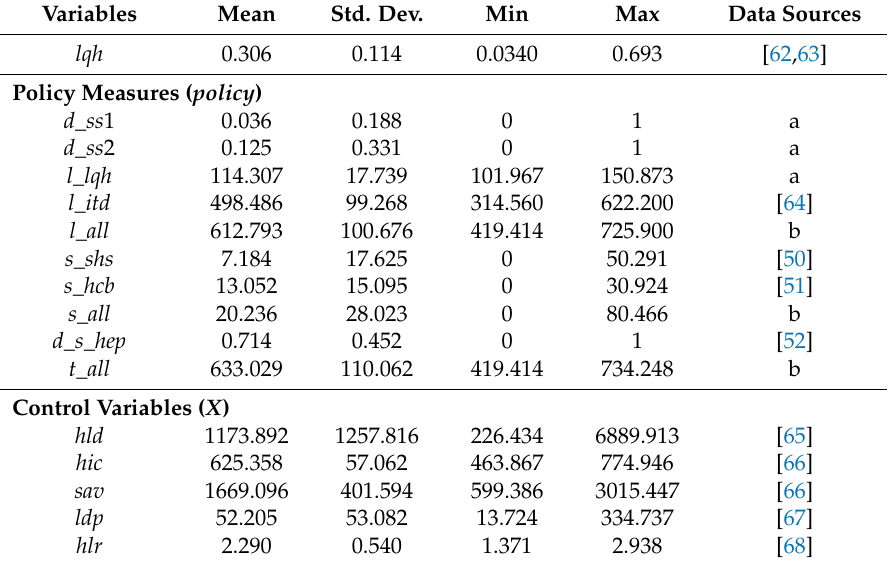
Table 4. Descriptive statistics and data sources of the